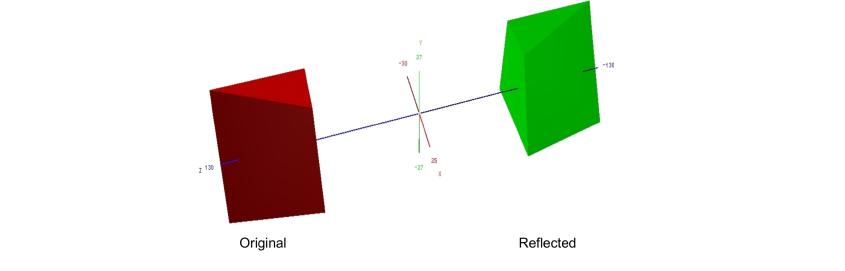
Figure 3. Example for a shape that is reflected (mirrored) into a left handed